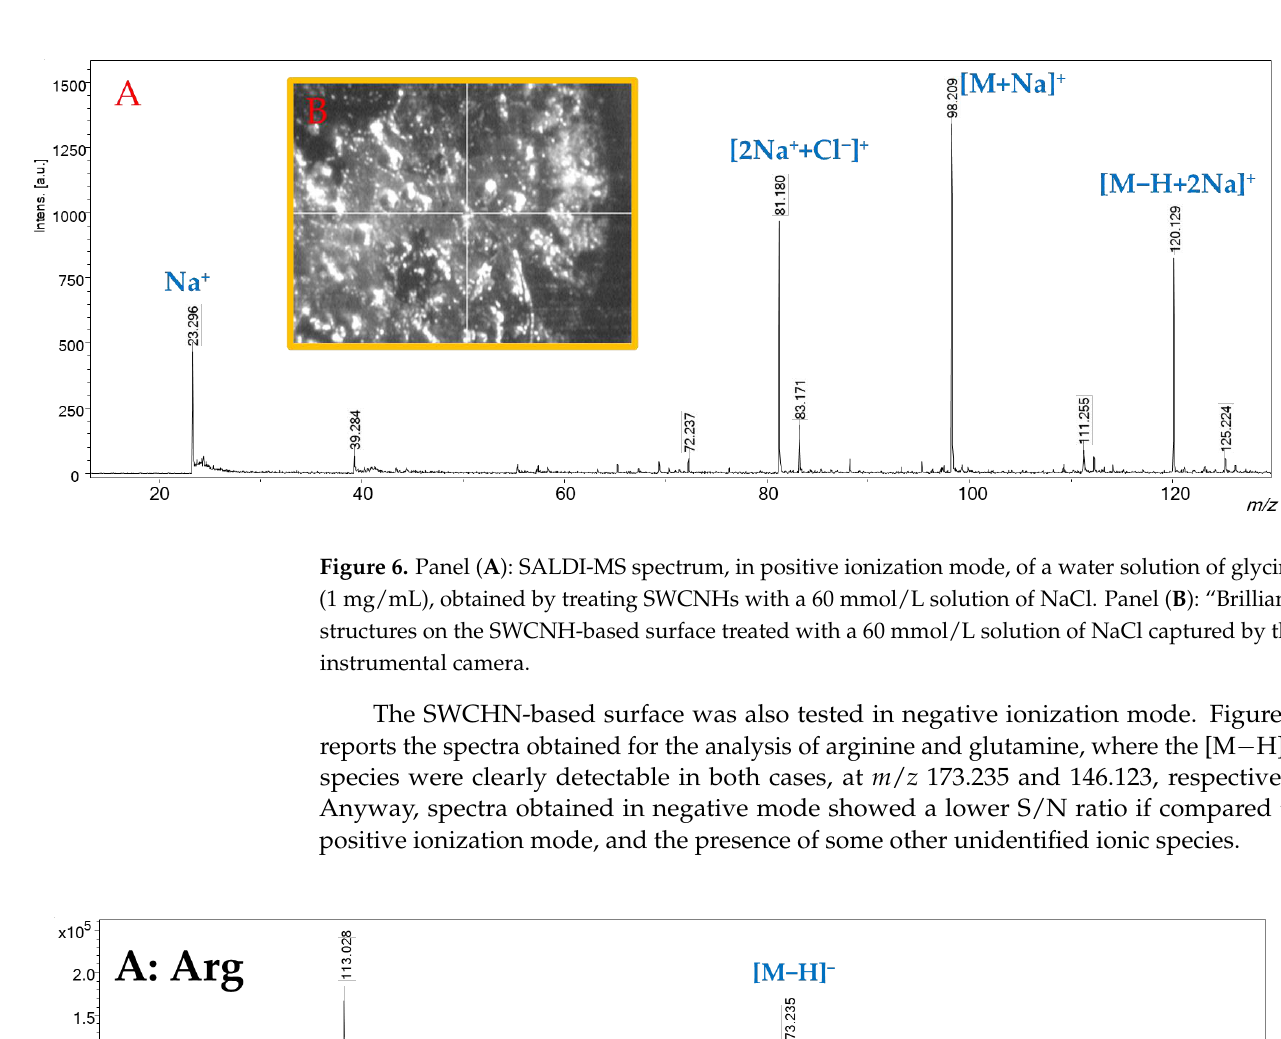
Figure 5. SALDI-MS spectrum, obtained in positive ionization mode by treating SWCNHs with a 6 mmol/L solution of NaCl. Panel ( A ): water solution of glycine (1 mg/mL). Panel ( B ): water solution of glycine (1 mg/mL).